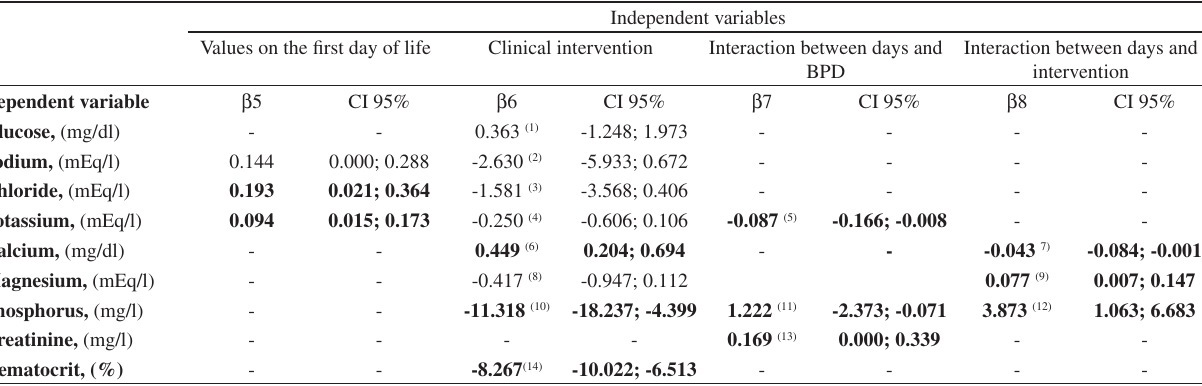
Table 6 - Multivariate model of the generalized estimation equation (GEE) of the longitudinal variation (from the first or second day of life to the seventh) of glucose, sodium, chloride, potassium, calcium, magnesium, phosphorus, creatinine and hematocrit adjusted to gestational age, daily variation, BPD and clinical intervention (when indicated).